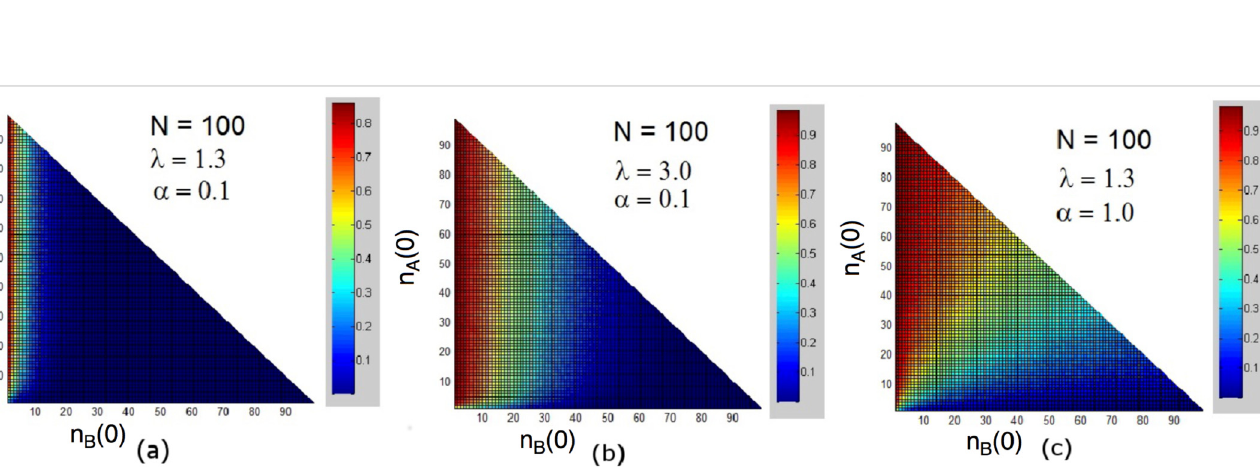
Fig 11. (Color online) Probability of the faster species ( A ) winning the competition for the process on a complete graph, as function of initial species populations, n A (0) and n B (0). Graph size: N =